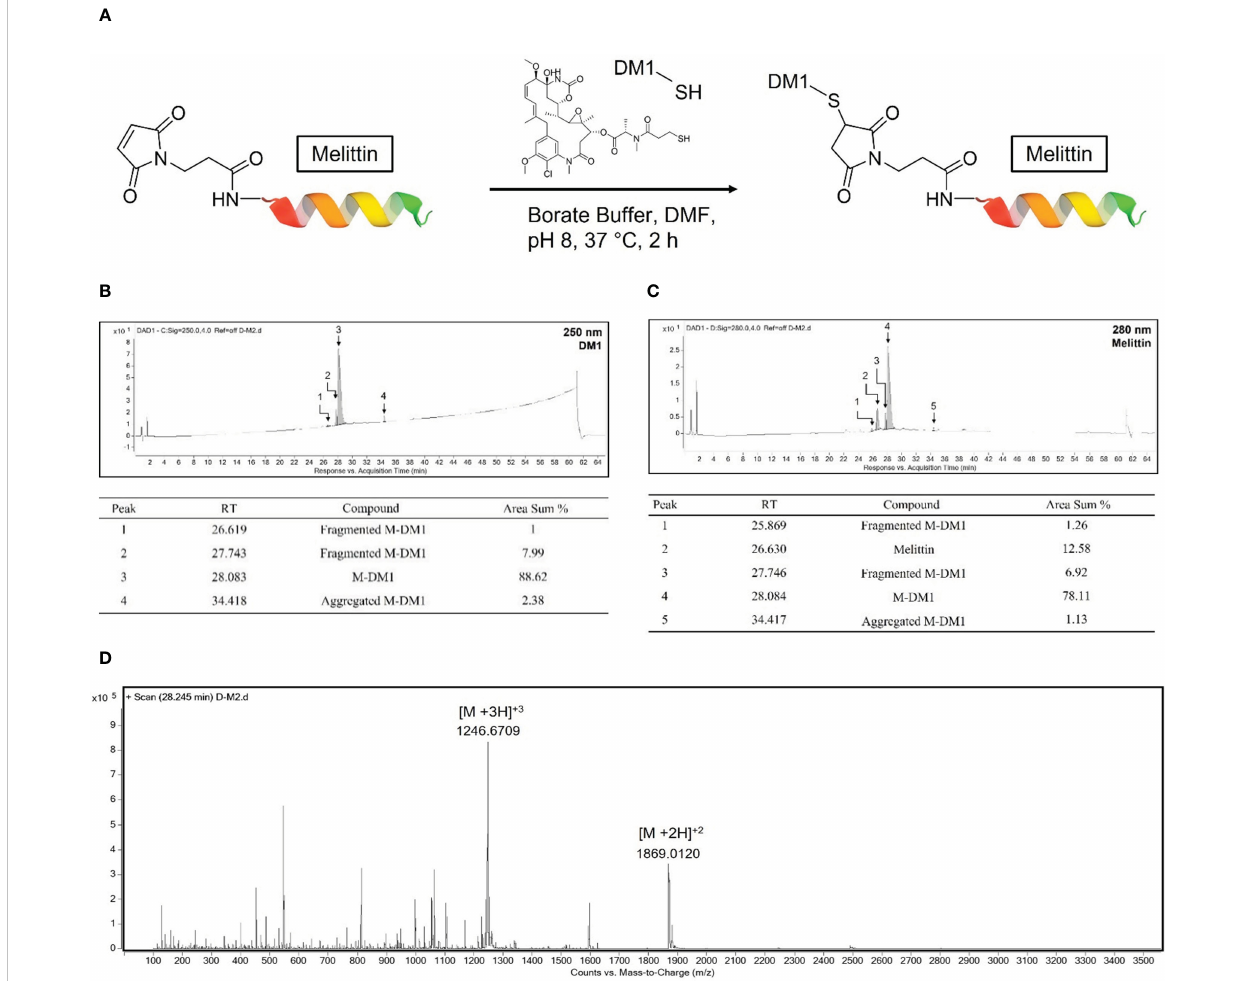
FIGURE 1 Conjugation of mertansine (DM1) to maleimide modi fi ed M and characterization of M-DM1. (A) Schematic representation of M-DM1. (B) RP-HPLC- DAD chromatogram of product at 250 nm for determination of DM1 and (C) at 280 nm for determination of M. (D) Charge state distribution of M- DM1 ions (Z = 2,